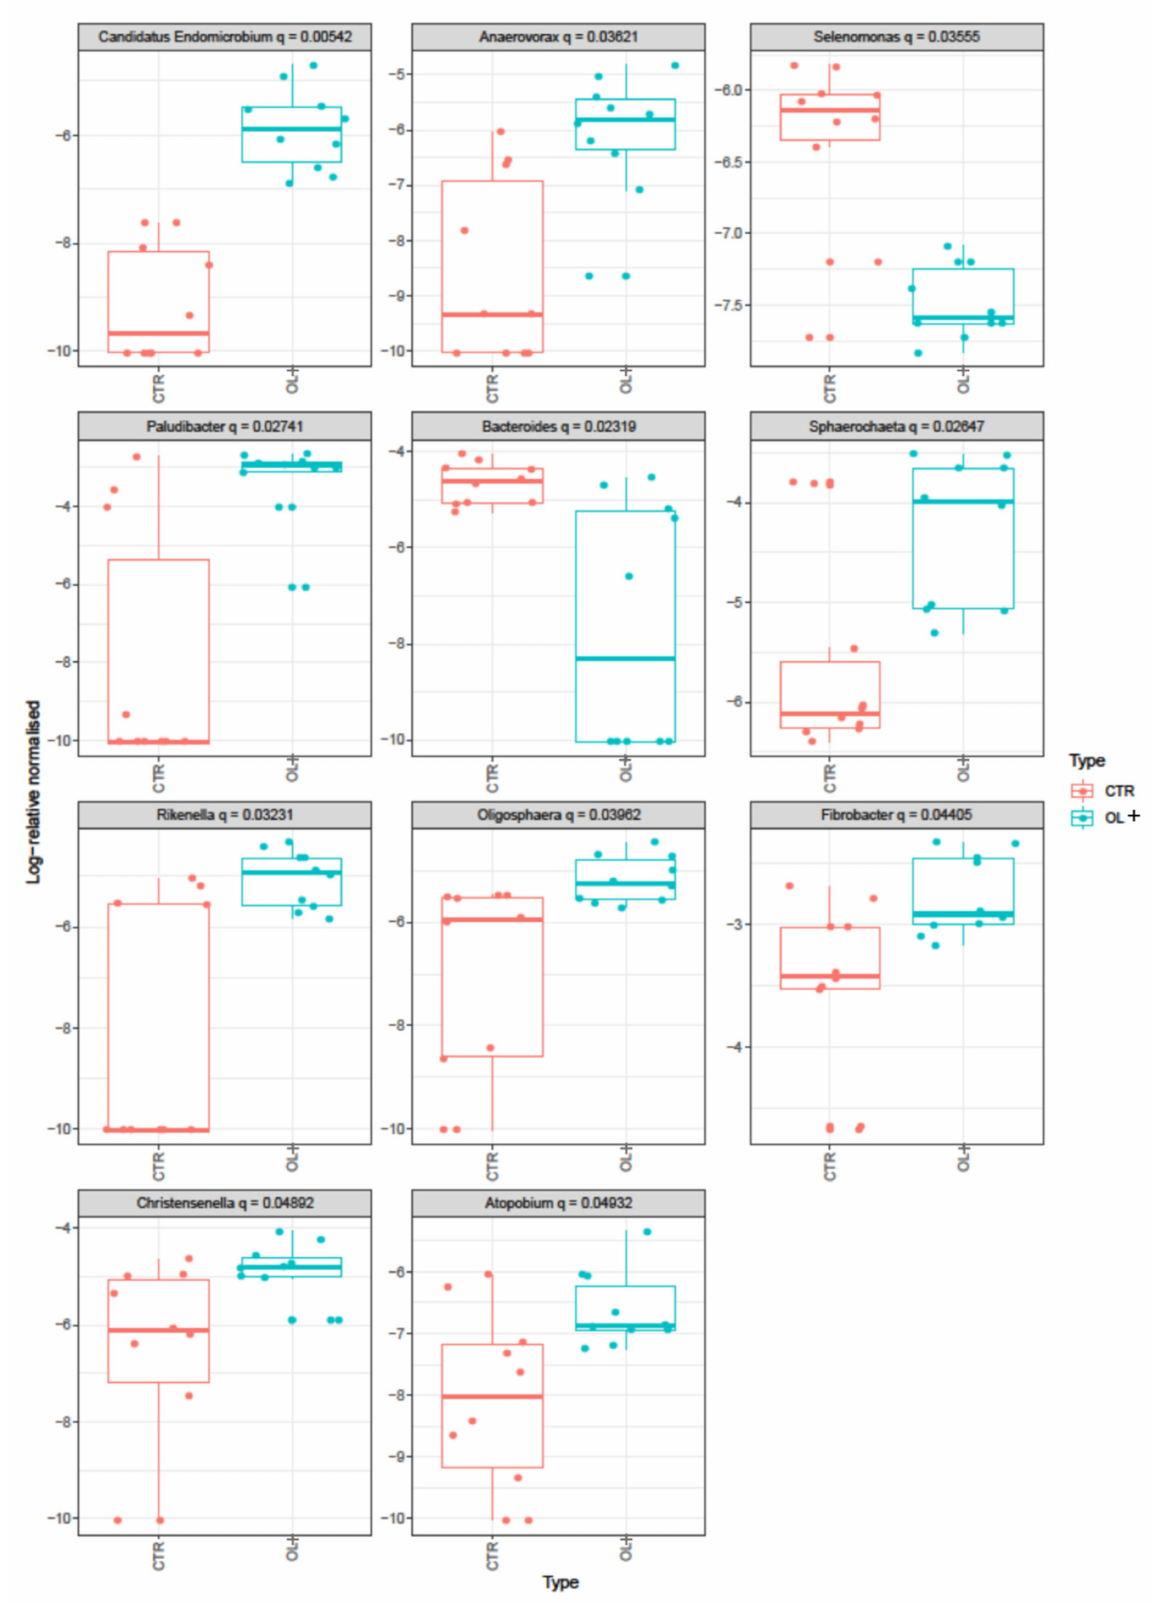
Figure 2. Boxplots showing the Bray-Curtis dissimilarities at genera level. The boxes in the plot represent the interquartile ranges, the horizontal lines give the position of the medians, the vertical bars indicate the range. The dots indicate